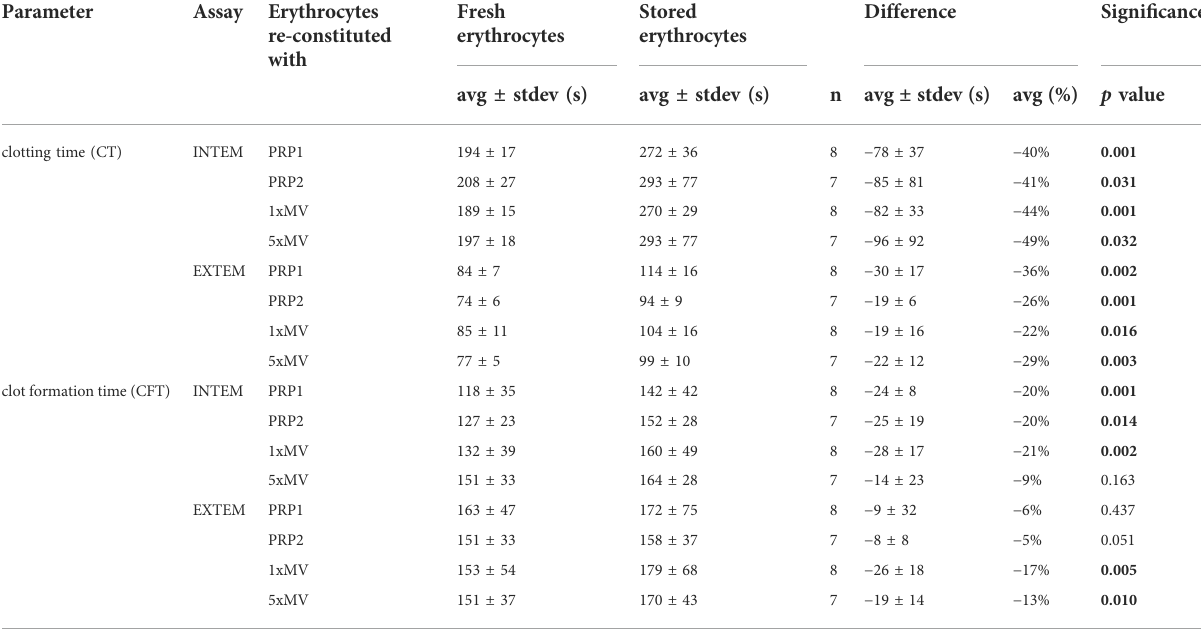
TABLE 2 Coagulation parameters in blood samples reconstituted with erythrocytes from stored PRBCs compared to fresh erythrocytes. Parameter